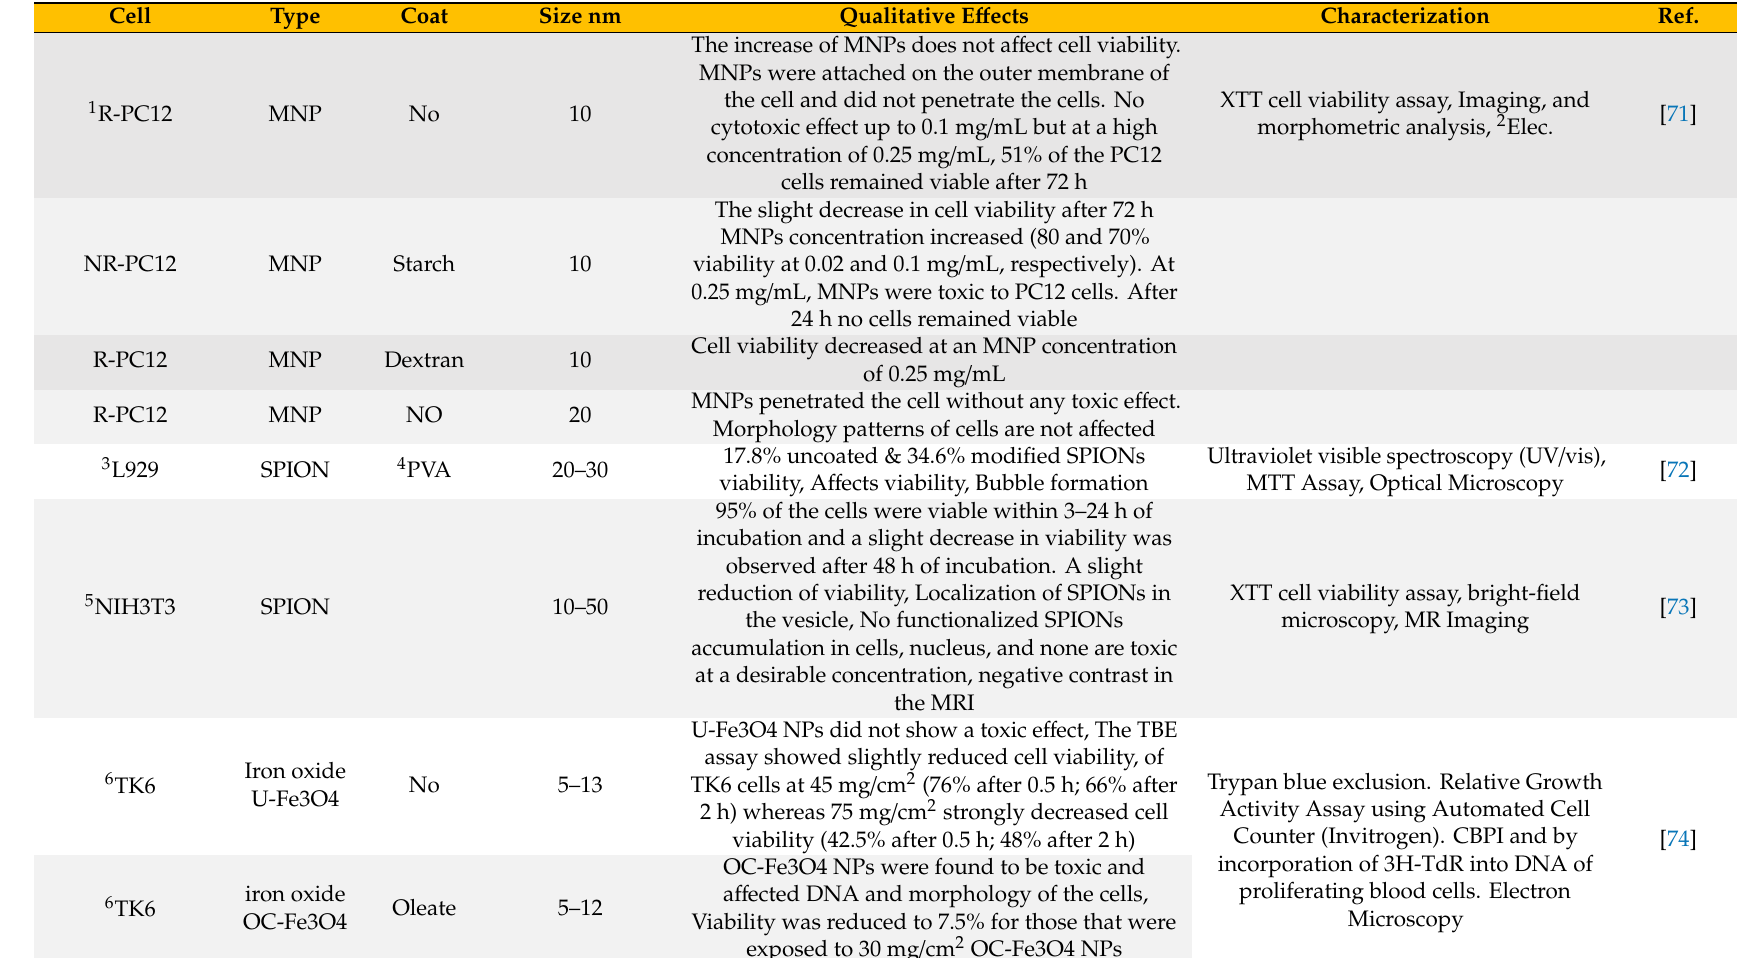
Table 1. In-vitro toxicity studies of